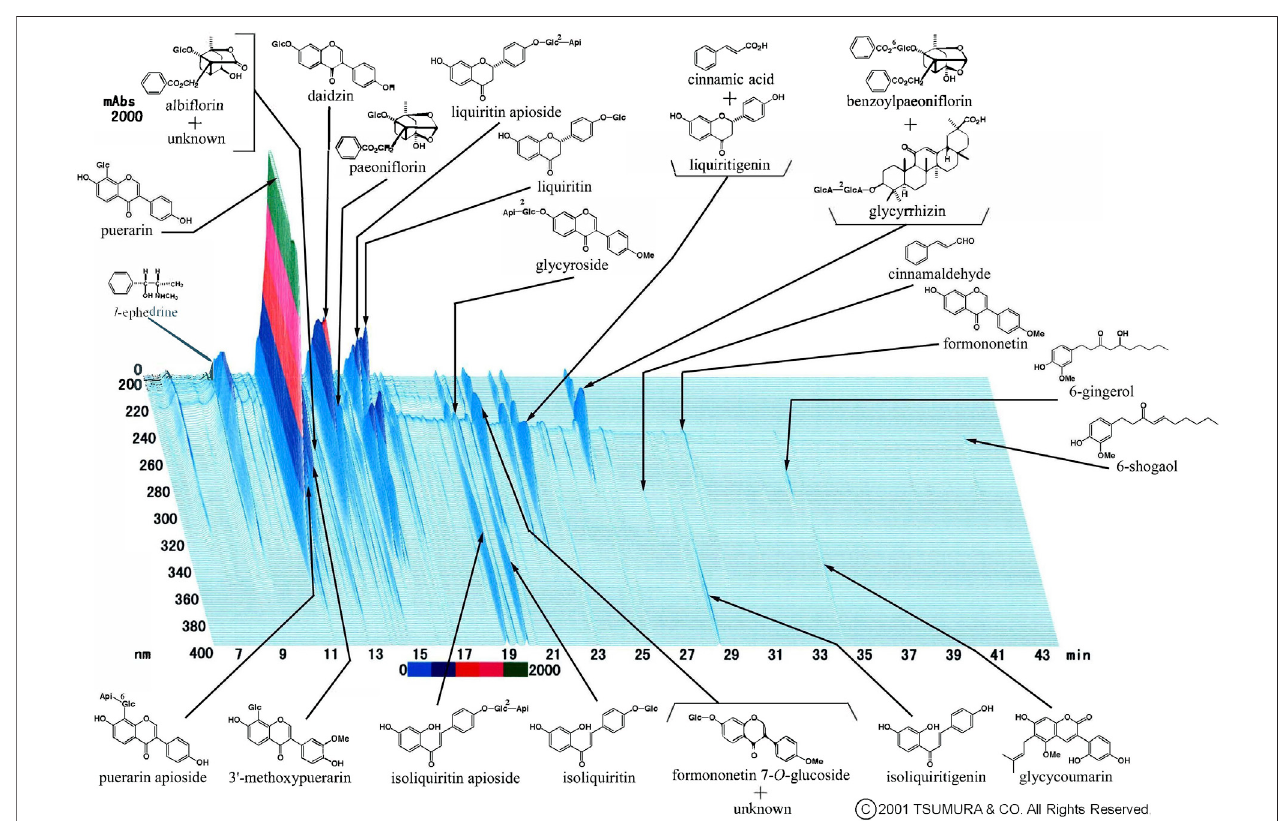
FIGURE 3 | Three-dimensional high-performance liquid chromatography fi ngerprints of Kakkonto Extract Granules for Ethical Use (Tsumura & Co.).